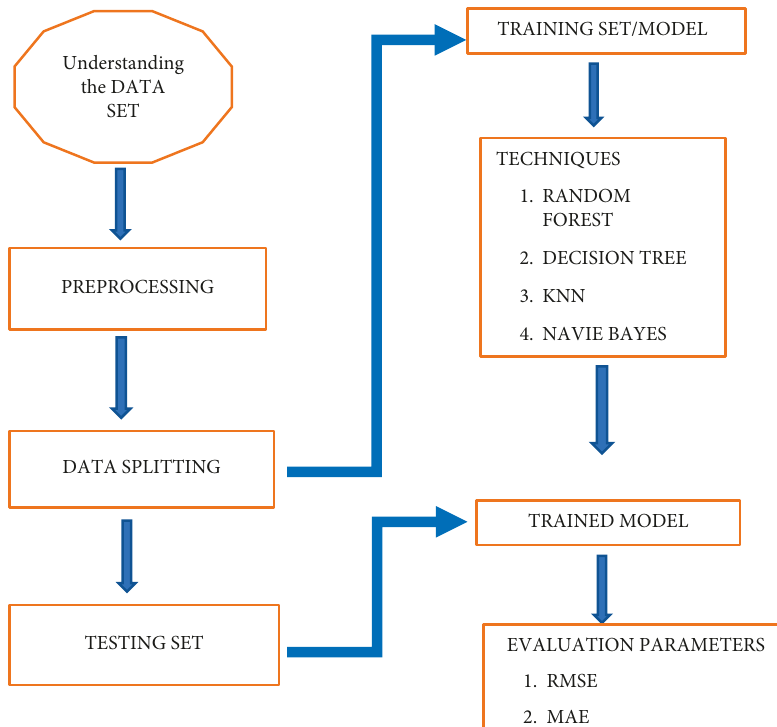
Figure 1: Framework for ML studies in the context of risk